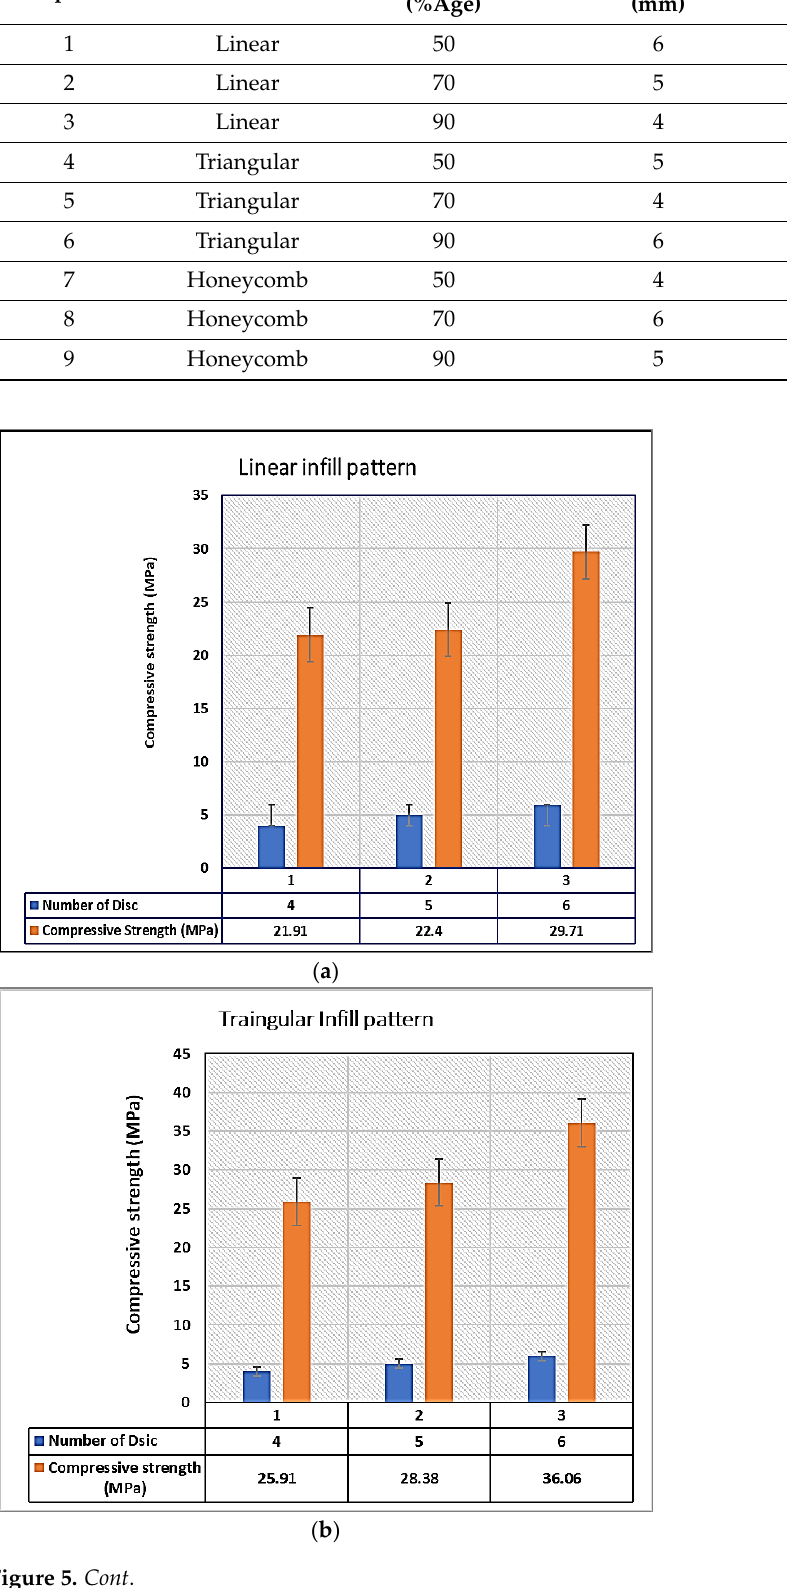
Table 5. Mechanical properties of LOM manufactured PLA samples.